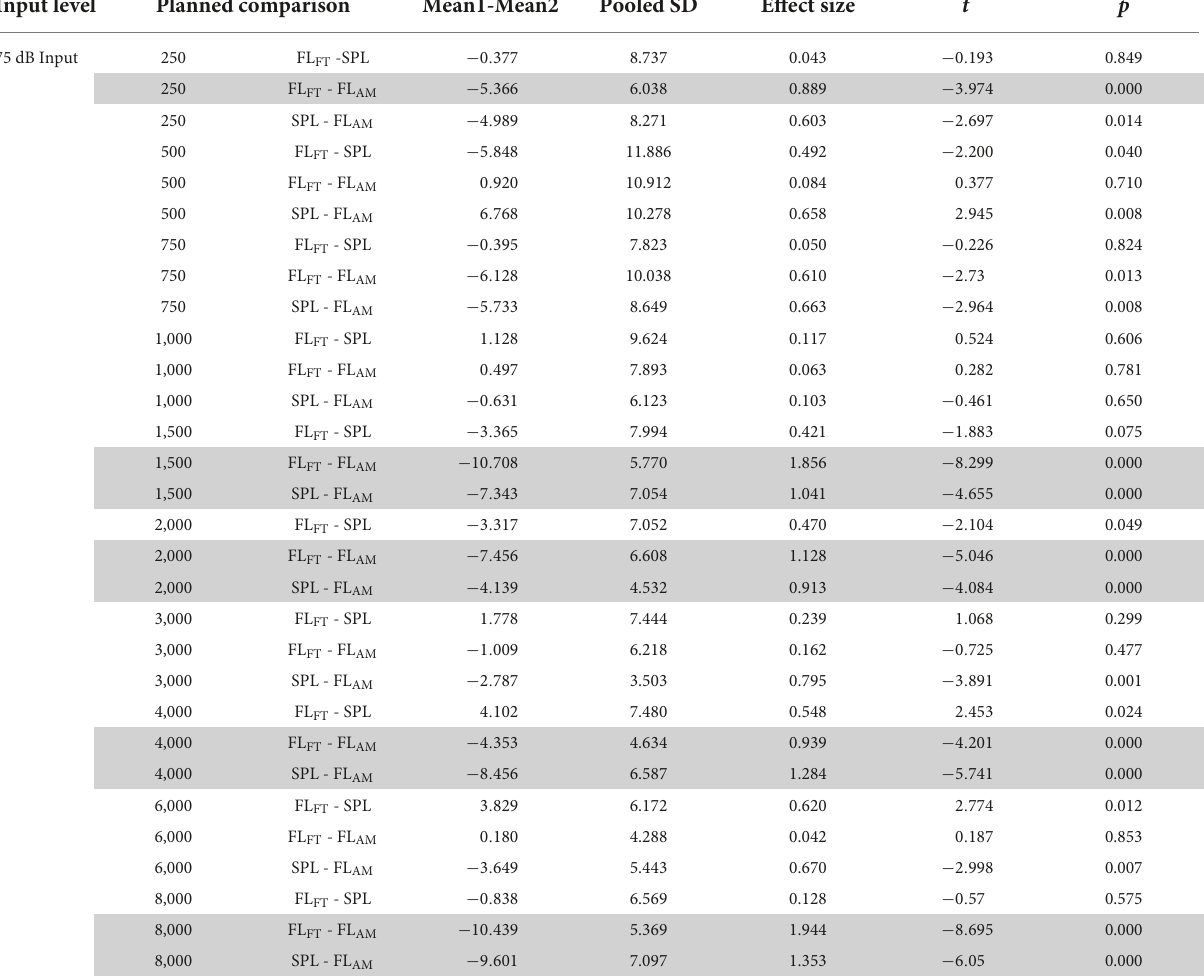
TABLE 3 Results from the t -test showing the p -values when comparing the audibility in 75 dB SPL input for the differences between the three measuring methods (FL FT represents the force transducer method, SPL represents the ear canal method, and FT AM represents the artificial mastoid method). The calculations of effect size are based on (Cohen, 1992). Large effect sizes of 0.8 or greater are highlighted in